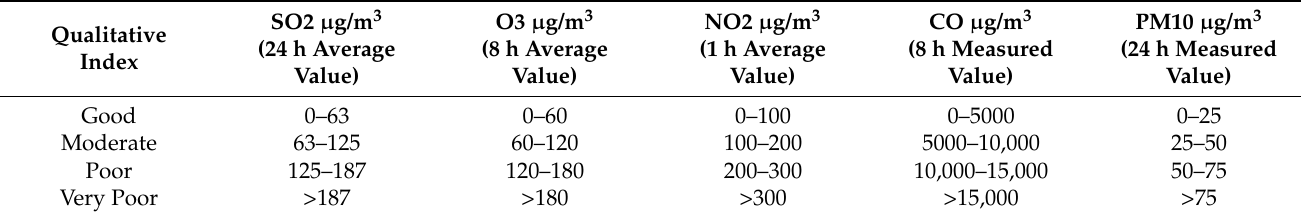
Table 1. Qualitative levels as referred to for the quantitative levels of each pollutant, and the averaging period used in each of them, following the European EEA